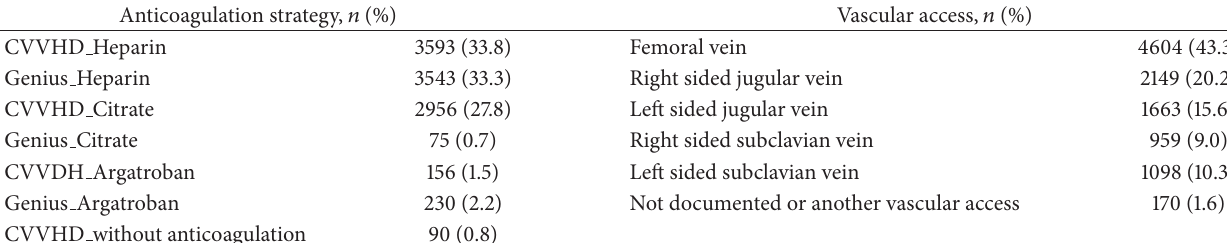
Table 2: Anticoagulation strategies and vascular access for renal replacement therapy.